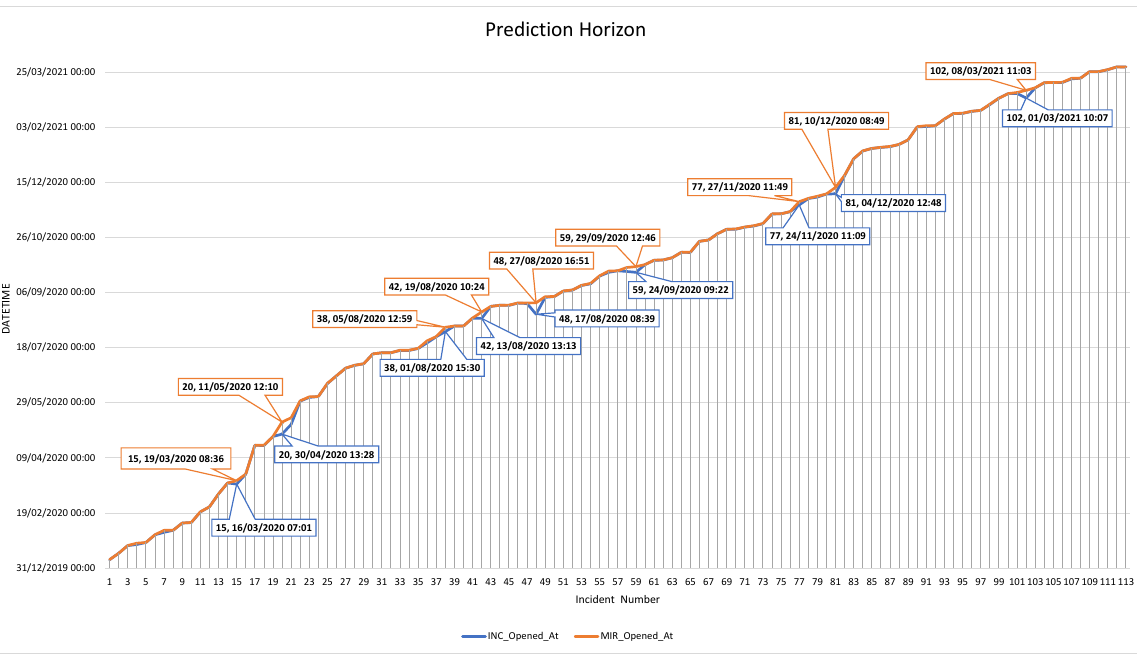
Figure 12. Prediction horizon comparison (MIR opened at vs. incident opened at. The blue line indicates IOA records while the orange shows the MOA